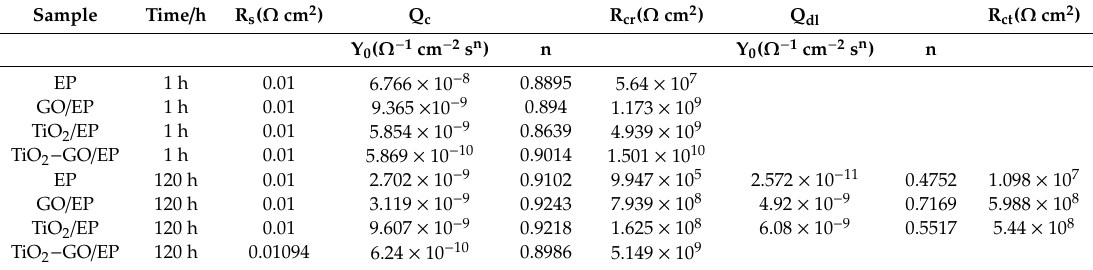
Table 1. The electrochemical parameters after fitting of all samples immersed in 3.5% NaCl solution for 1 and 120